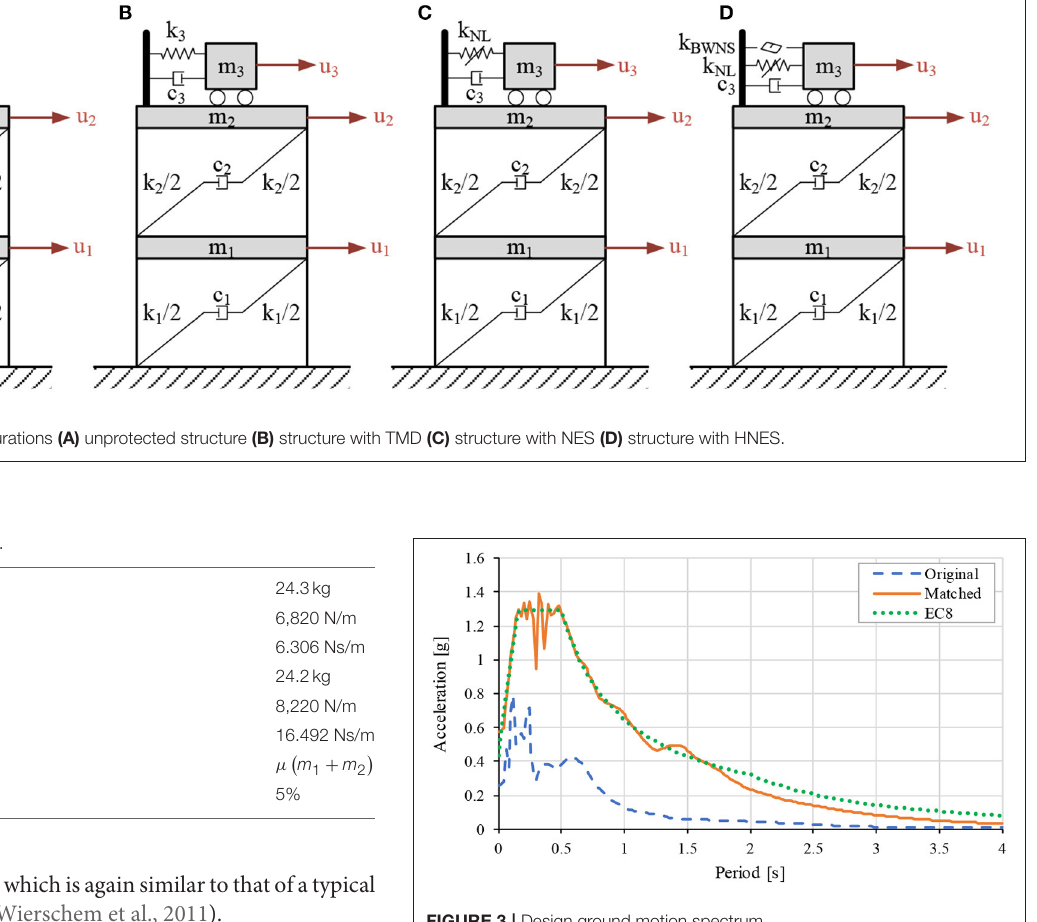
FIGURE 3 | Design ground motion